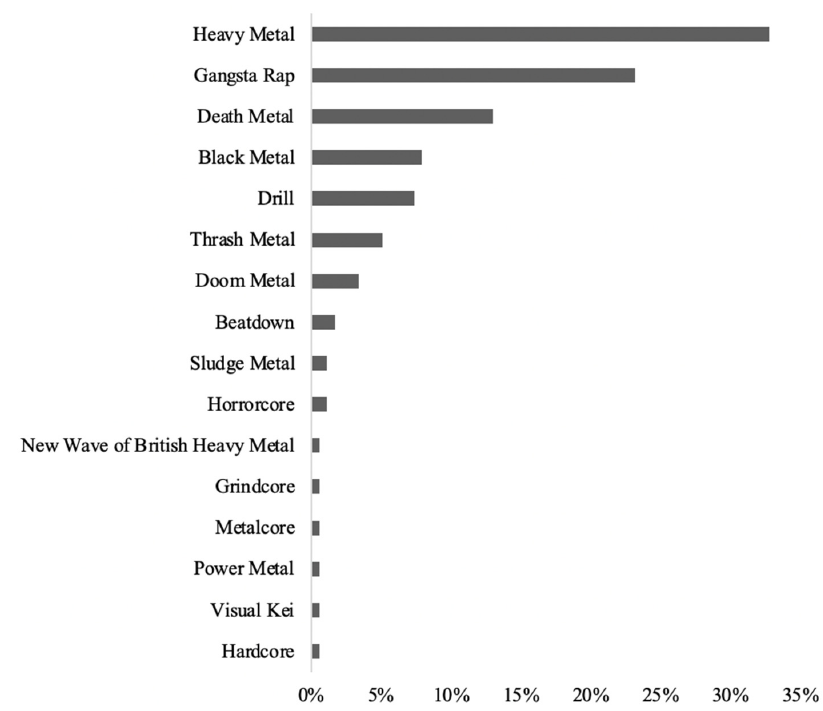
Figure A1. List of genres selected as favourite and most passionate about by participants. Percentages refer to the proportion of participants who selected each genre as their favourite.